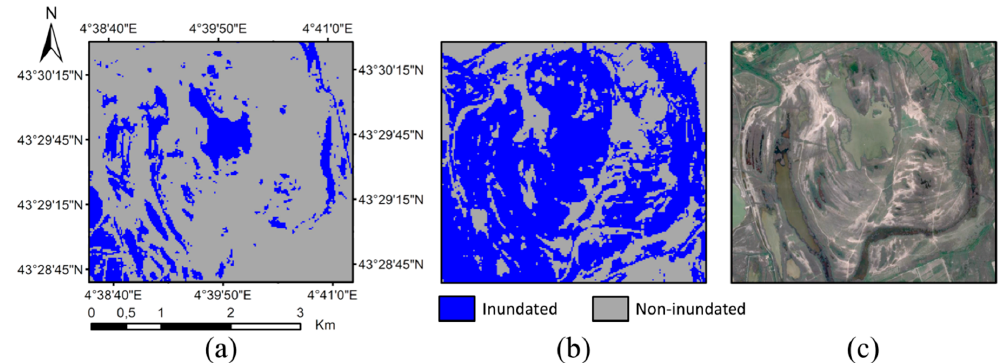
Figure 11. Zoomed part of the inundation map generated on 23 January, 2018 using: ( a ) “Alt3 (OTSU)”, and ( b ) reference map. In this region of the Camargue, the main habitat is halophilous scrubs (Salicornia marshes). Areas of open water and bare ground are clearly visible on the Google Earth image of the same area acquired on 22 April, 2018 shown in ( c ).